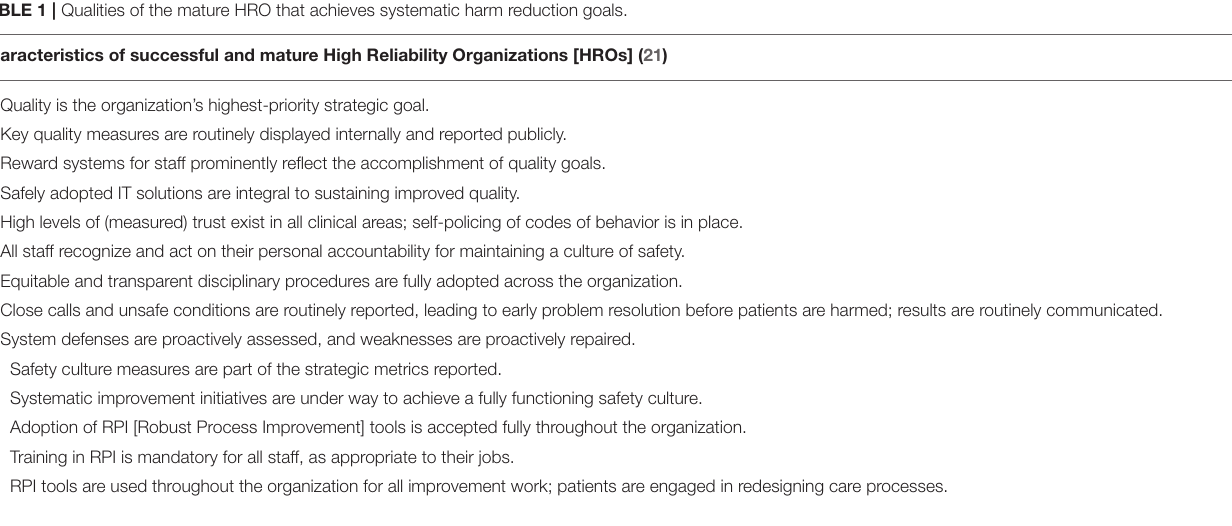
TABLE 1 | Qualities of the mature HRO that achieves systematic harm reduction